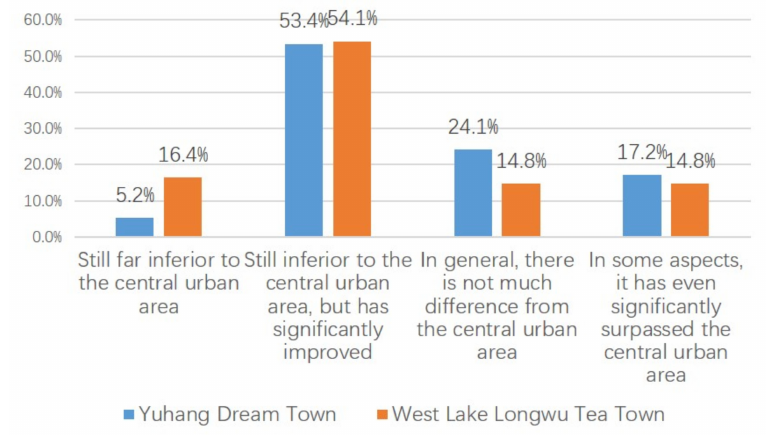
Figure 37. Respondents’ evaluation of local development under the local CT practice compared with the development of central urban areas (source: authors).